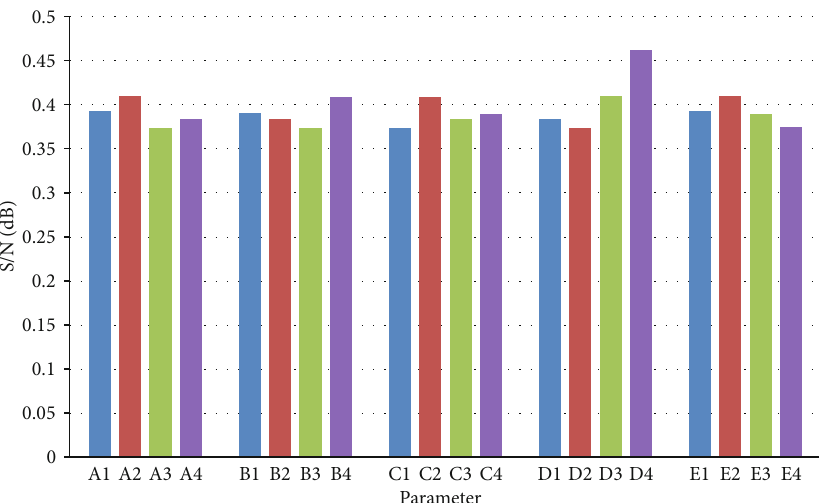
Figure 10: Variations in the signal-to-noise (S/N) ratio with factor levels for warpage phenomena of the thin-walled part by the experiments (using thin-wall injection molding).